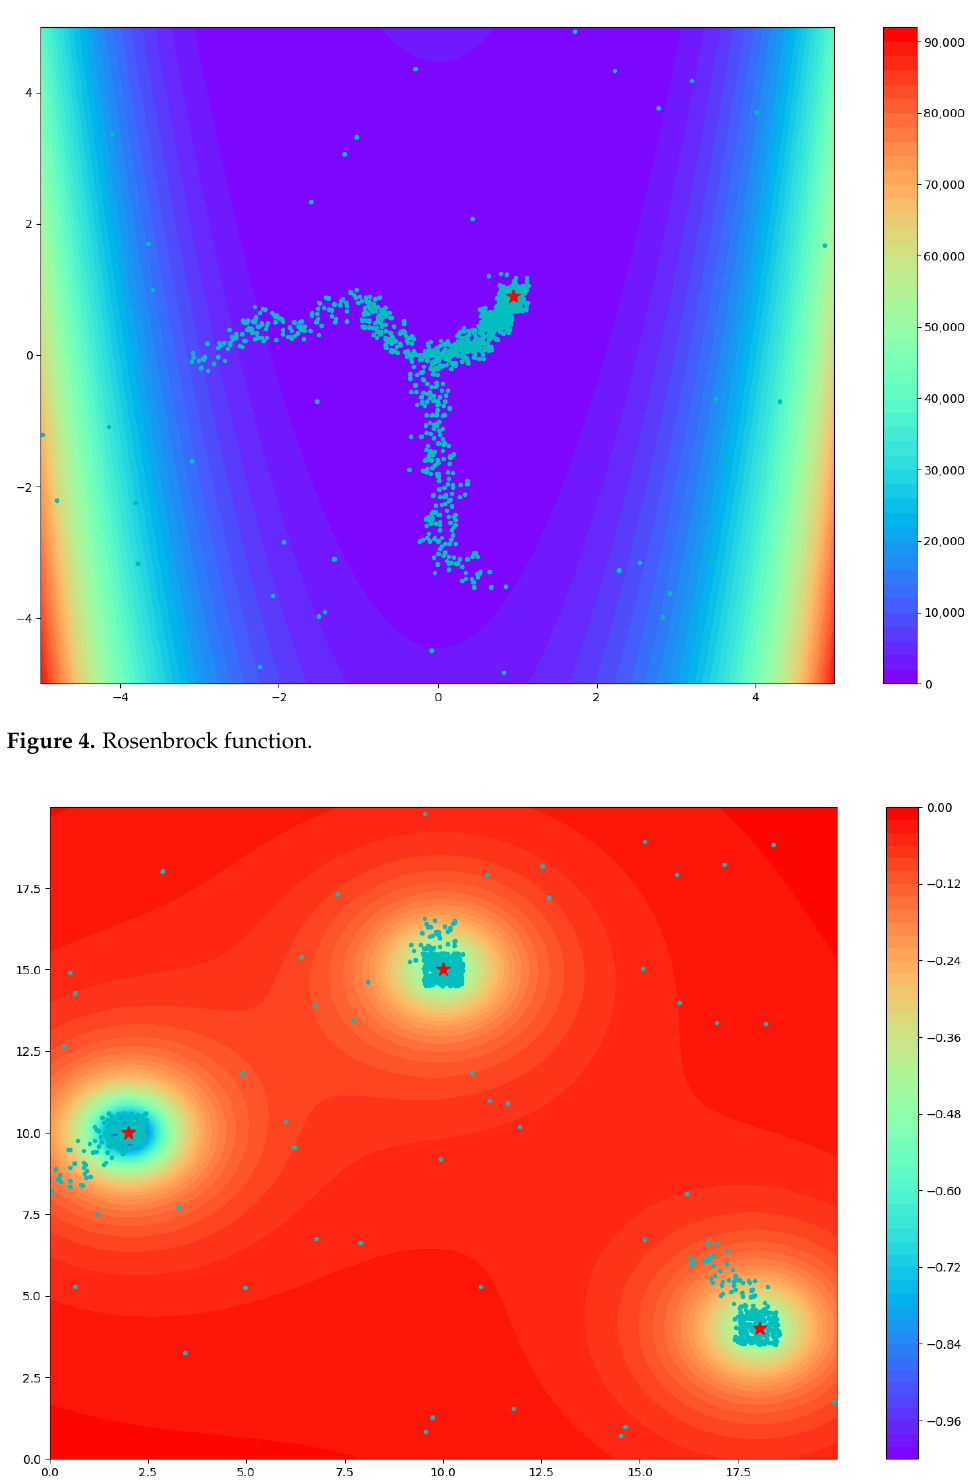
Figure 5. Shekel